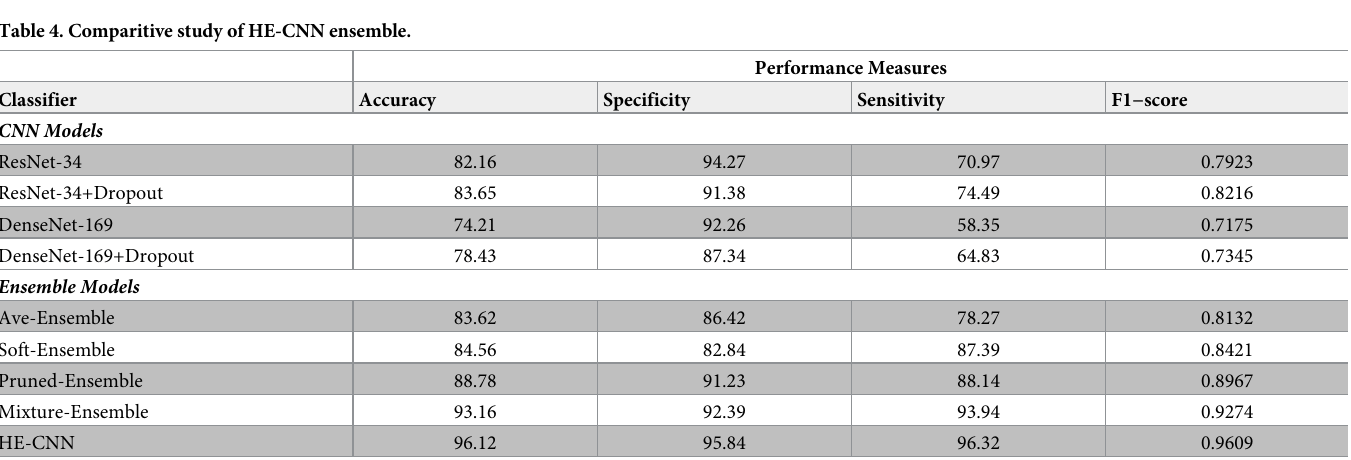
Table 4. Comparitive study of HE-CNN